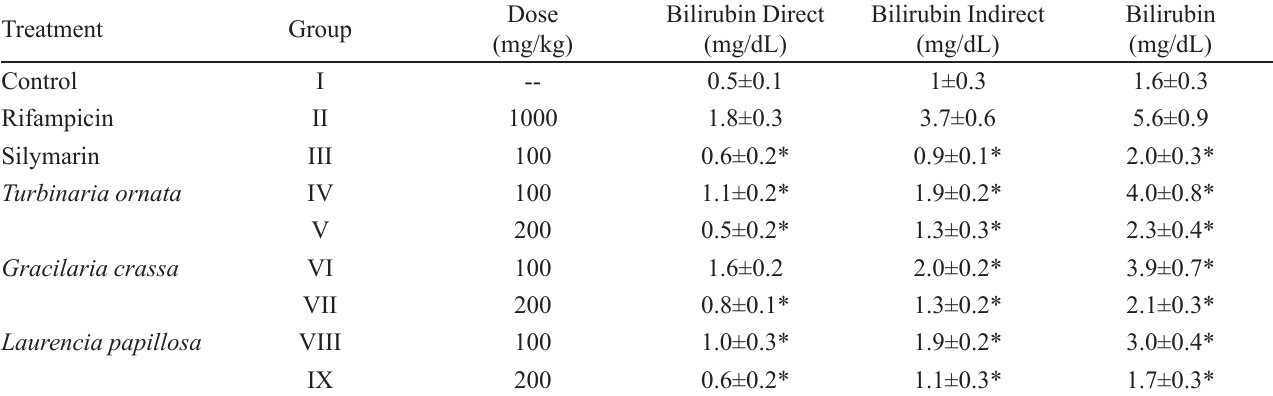
TABLE II - Hepatoprotective activity of seaweed Turbinaria ornata , Gracilaria crassa and Laurencia papillosa acetone extracts Treatment Group